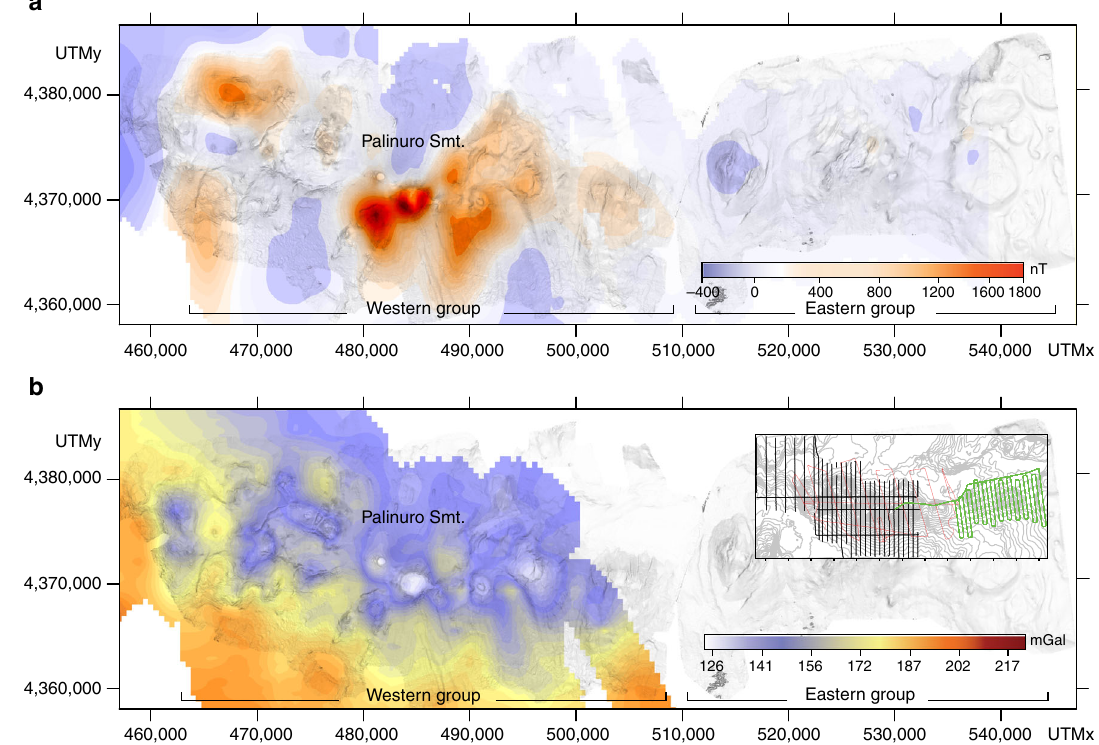
Fig. 6 Magnetic and gravity anomaly maps. a RTP magnetic anomaly (grid cell size 400 m) overlaid on the shaded relief bathymetry of the STEP volcanic chain; b Bouguer gravity anomaly (grid cell size 500 m). Inset shows the survey lines: the gravity and magnetic survey acquired during PALI2008 cruise is reported in black, and the magnetic lines acquired during the Aeolian 2007 and SAFE 2015 cruises are reported in red and green,